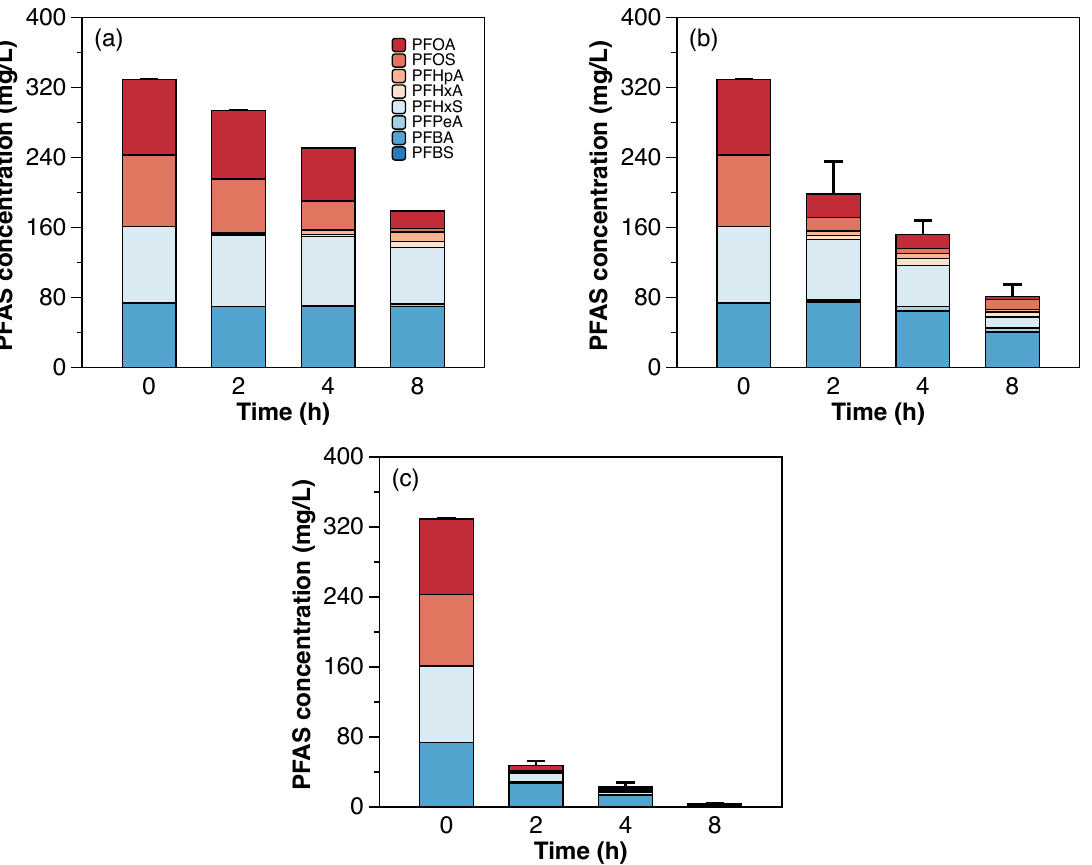
Figure A3. Decrease in concentration of individual PFAAs over time during the electrochemical treatment of a synthetic still bottoms solution at the laboratory scale. The applied current densities were: ( a ) 10 mA/cm 2 , ( b ) 25 mA/cm 2 , and ( c ) 50 mA/cm 2